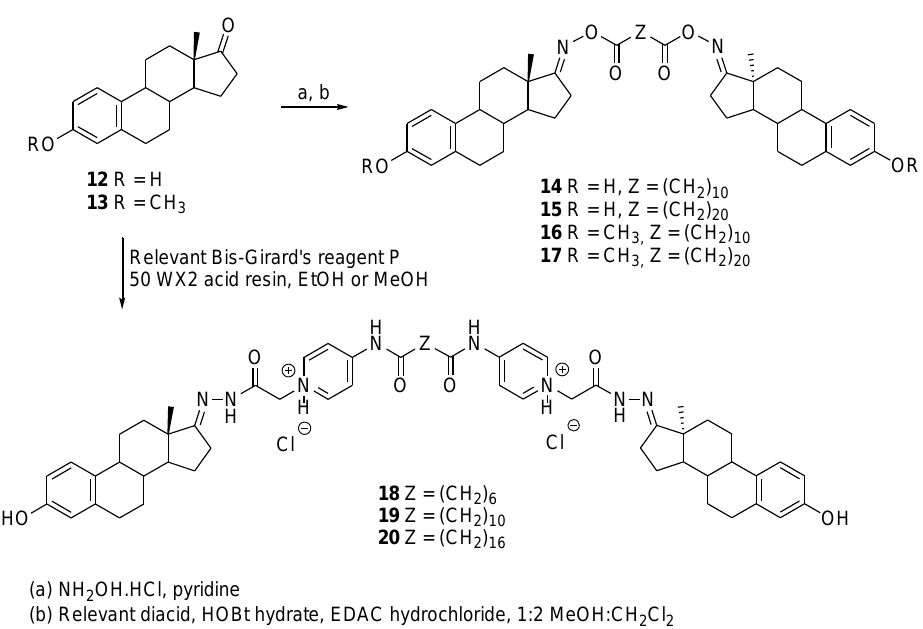
Molecules 2021 , 26 , x FOR PEER REVIEW Figure 5. Synthesis of estrogen dimers ( 18 – 20 ) possessing amide linkers at the C-17 position.